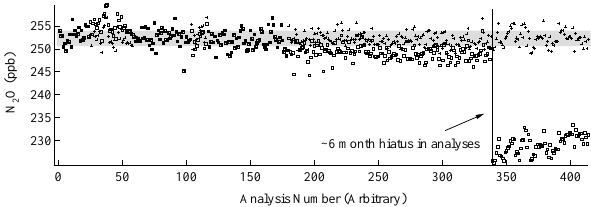
Figure 3. N 2 O standard reproducibility: the reproducibility and drift in the N 2 O calibration of the same period of analysis as in Fig. 2. The black crosses are the N 2 O of the NOAA1 standard as determined by the daily calibration. The open squares represent the same data if the calibration was fixed to a set value at the beginning of analysis (time 0). This shows both a small drift from about num- ber 0 to 300 ( ∼ 4 months) and a major shift in the values around 340, which represents a 6-month hiatus and retuning of the ion source.